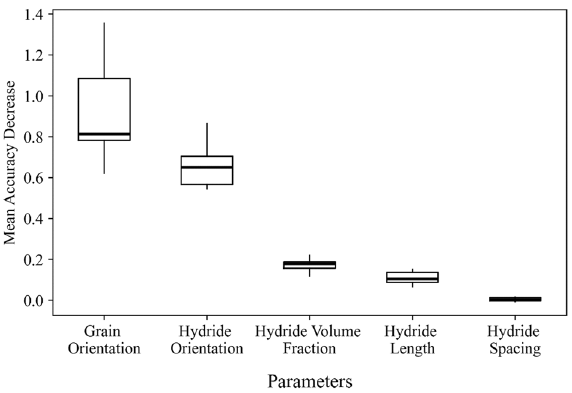
Figure 4. Permutation importance study . Performed for all parameters, calculated for the neural network trained for the 2.75% strain